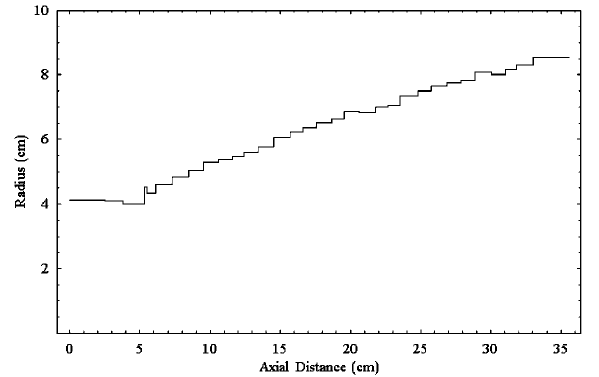
FIG. 7. End taper designs produced by the mode matching optimization code.